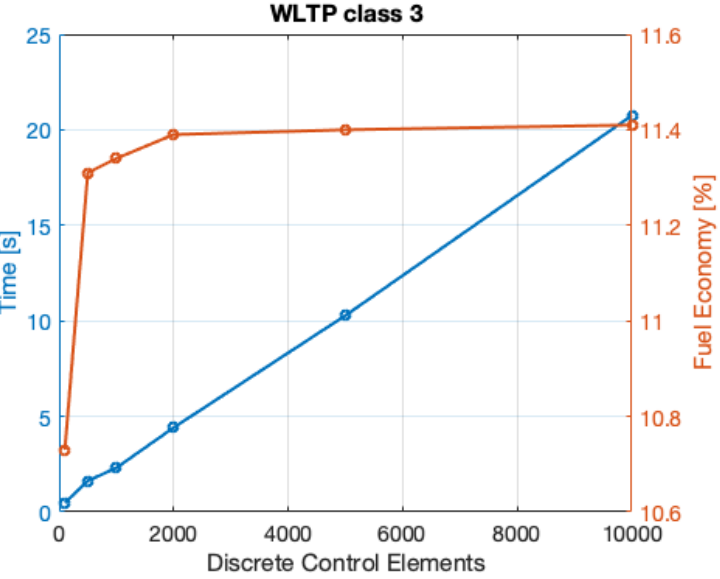
Figure 10. Influence of the number of the discrete control elements on the computational and fuel economy achieved through the ECMS-based technique on the WLTP driving cycle.